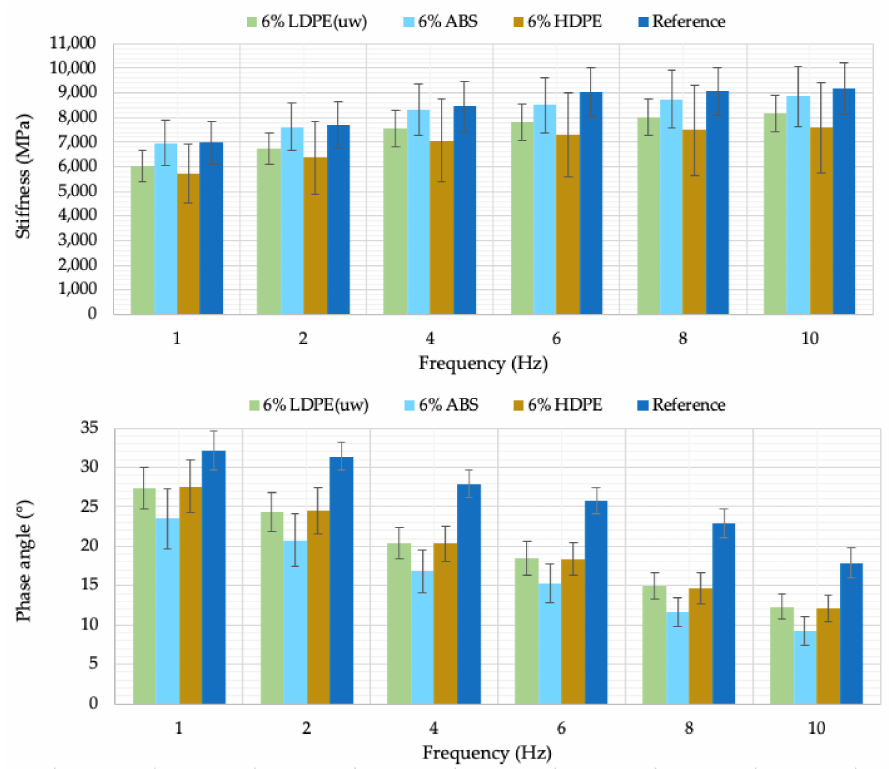
Figure 10. Stiffness and phase angle results obtained from four-point bending tests at 20 ◦ C as a function of the loading